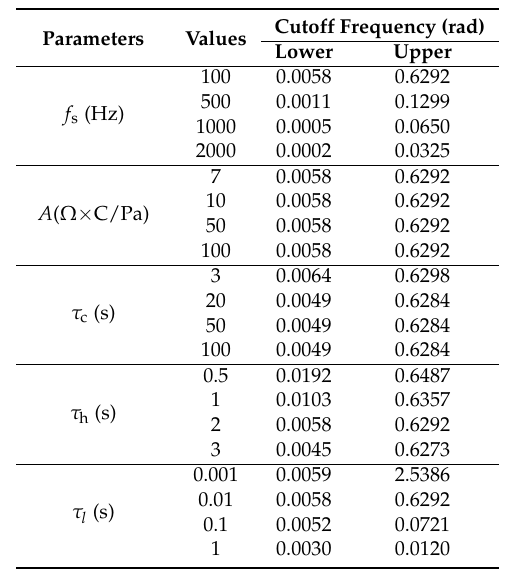
Figure 6. Frequency distributions of leak pressure signals: ( a ) example 1, ( b ) example 2. Table 1. The effect of different parameters on the cutoff frequency result of the